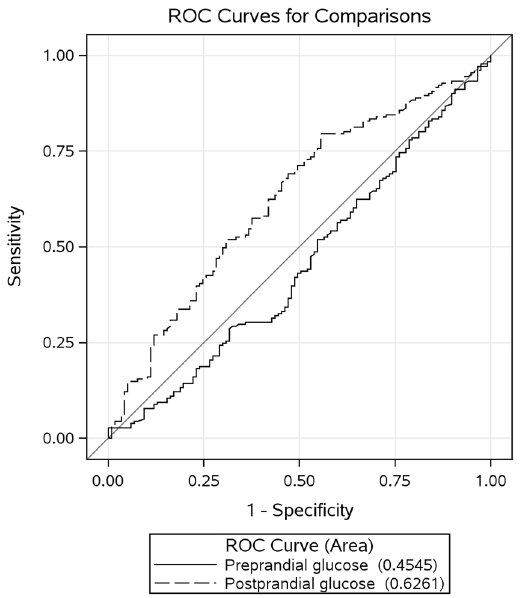
Figure 3. ROC curves for the mean preprandial and postprandial glucose levels in predicting GDM recurrence (N =